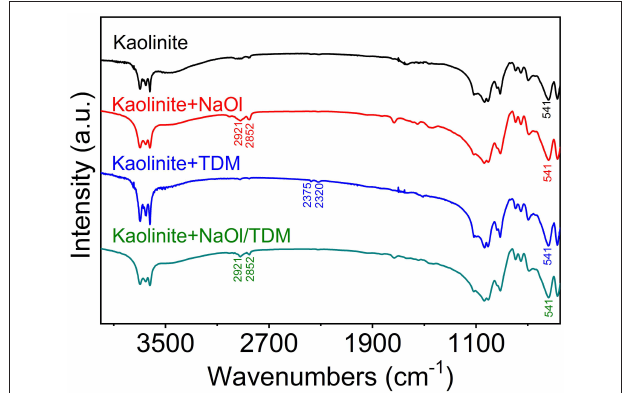
FIGURE 10 | FTIR spectra of diaspore in different collectors (NaOl: TDM mole ratio = 8:2). FIGURE 11 | FTIR spectra of kaolinite in different collectors (NaOl: TDM